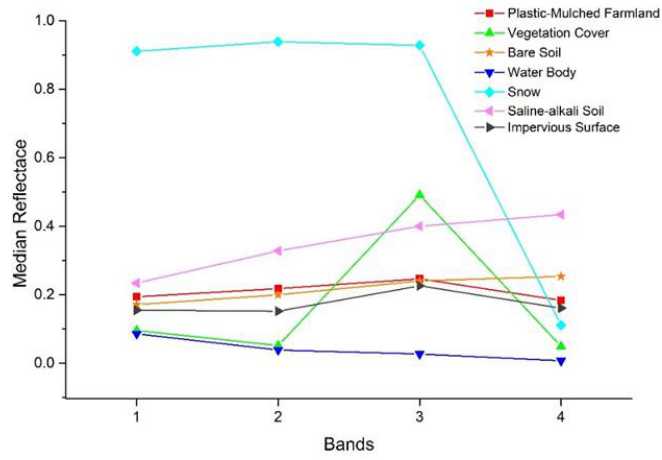
Figure 4. Spectral separability of different ground objects on the different bands of Sentinel-2 MSI imagery (1: Blue; 2: Red; 3: NIR; 4: SWIR2).